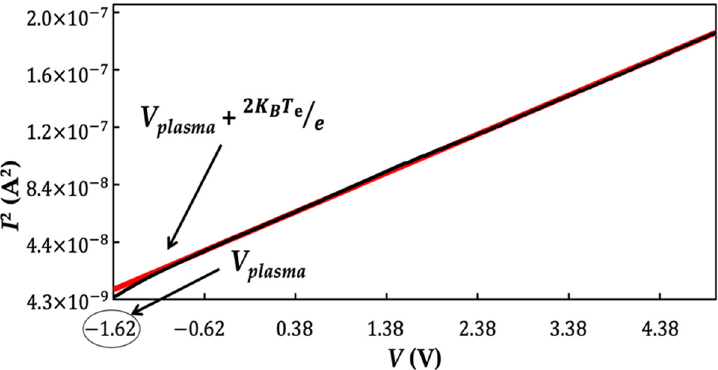
Figure 5. I 2 versus V curve (black line) of zone I of the experimental IVCP illustrated in Figure 4. The linear zone is constituted by 335 points and fits very well with a linear behavior since the correlation coefficient of the linear regression (red line) is r = 0.9993.